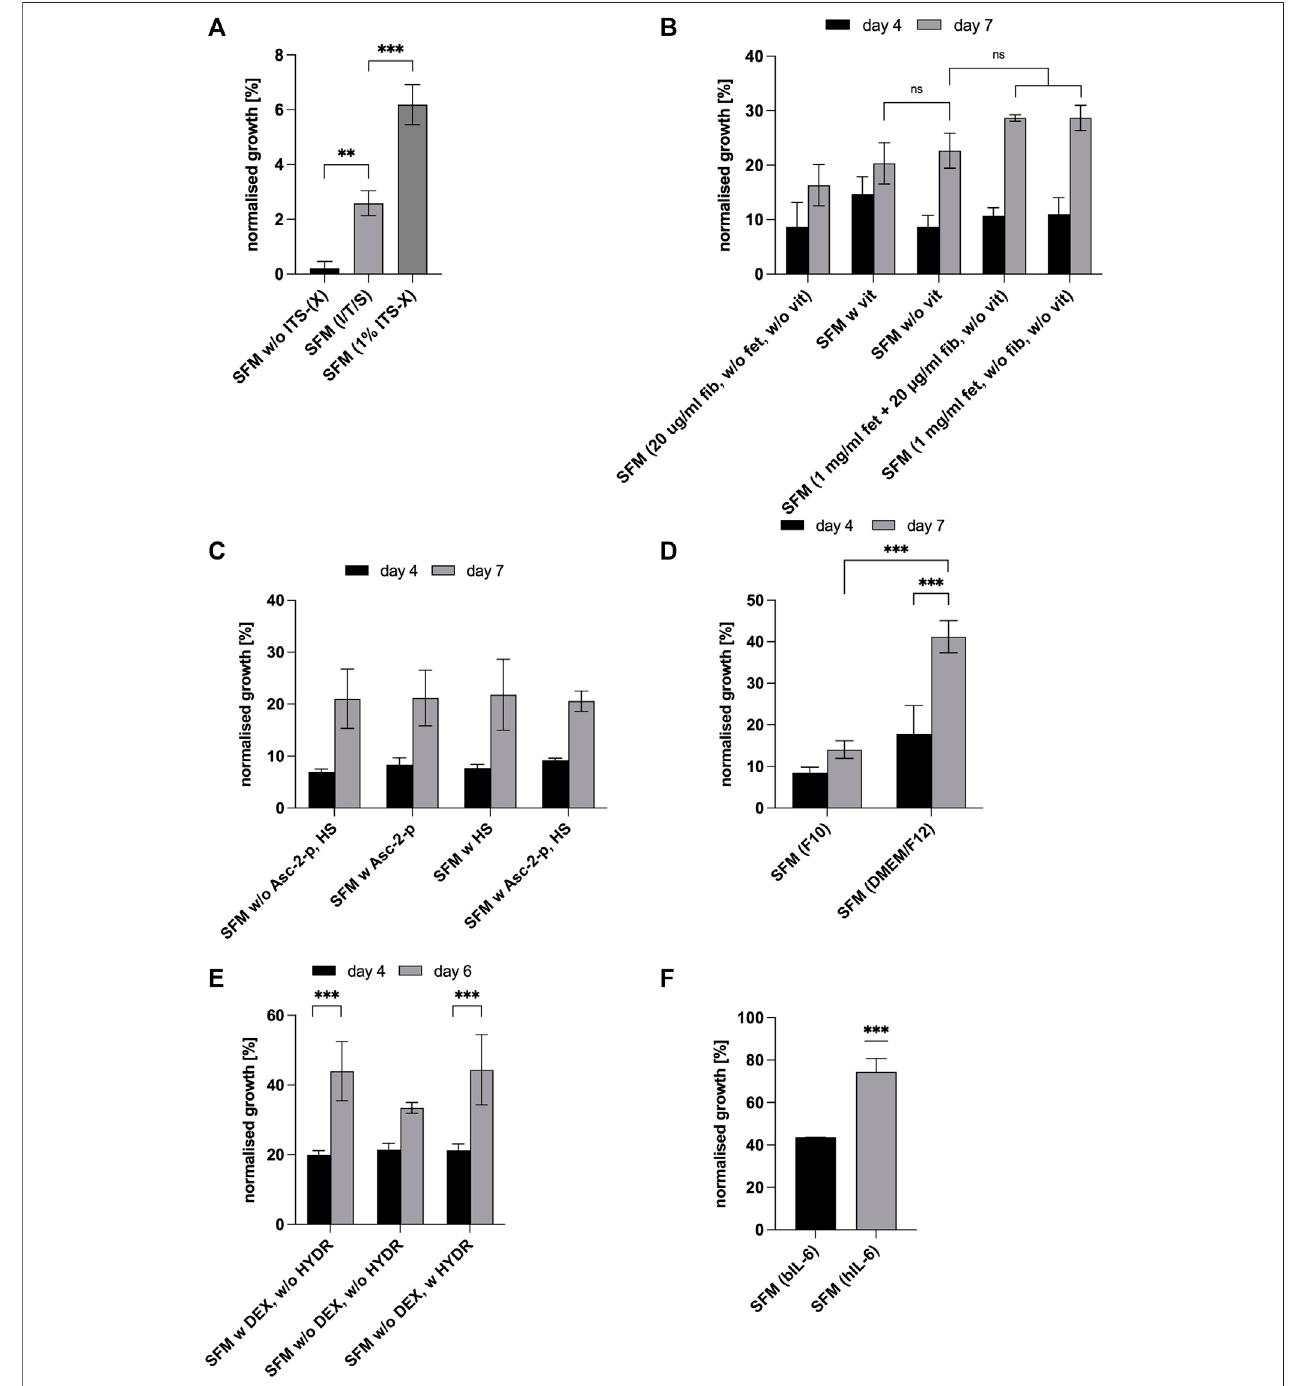
FIGURE 2 | For all graphs, cell growth was measured with MTS or HCA and expressed as percentages of GM (control, not shown in graph). (A) Effect of the addition of insulin (I), transferrin (T) and sodium selenite (S) in comparison to supplementation of SFM with commercial Gibco ® ITS-X (X = Ethanolamine) at day 7 of culture. Asterisks (** p < 0.01, *** p < 0.001) indicate signi fi cant effect of the presence of ITS (-X) in the serum-free formulation [SFM w/o ITS (-X)]. (B) Effect of attachment factors [vitronectin (v), fi bronectin ( fi b) and fetuin (fet)] at different concentrations on cell growth in SFM and expressed as % of growth achieved in GM (bars not shown)ondays4and7. (C) EffectofL-Ascorbate-2-phosphateandheparansulphateoncellproliferationondays4and7.Forallconditions,timesigni fi cantlyimpacted cell proliferation ( p < 0.001). (D) Effect of different basal media and time, DMEM/F-12 and Ham ’ s F-10 Nutrient Mix on cell expansion on days 4 and 7. Asterisks (*** p < 0.001) indicate that the mean value is signi fi cantly different between DMEM/F12 & F10 and that there is a signi fi cant time effect for DMEM/F12. (E) Effect of dexamethasone and hydrocortisone on cell proliferation on days 4 and 6. Asterisks (*** p < 0.001) indicate that there is a signi fi cant time effect for — DEX + HYDR. (F) Comparison of bIL-6 with hIL-6 on days 4 and 6. SFM with hydrocortisone and DMEM/F12 in both cases.